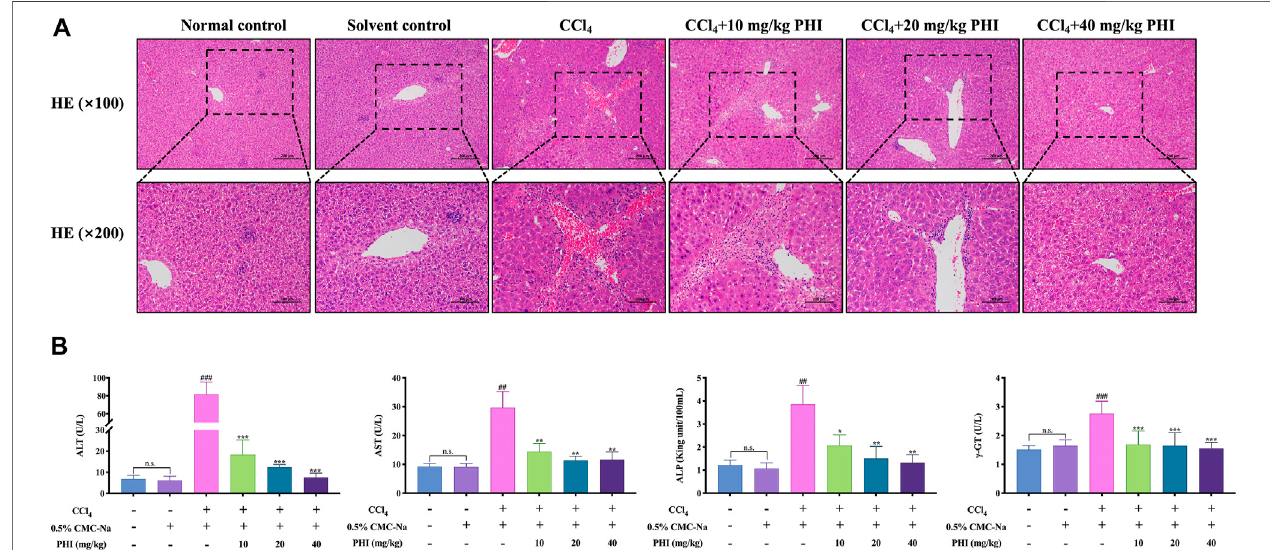
FIGURE2| EffectofPHIonthepathologicalandserumbiochemicalindexesofliver fi brosisinmice. (A) HEstainingofliver( × 100and × 200). (B) SerumALT,AST, AKP and γ -GT activity. Data was expressed as the mean ± SD ( n (cid:1) 6). ## p < 0.01, ### p < 0.001 represent compared with solvent control group. * p < 0.05, ** p < 0.01, *** p < 0.001 represent compared with CCl 4 group. n. s indicates no signi fi cant.